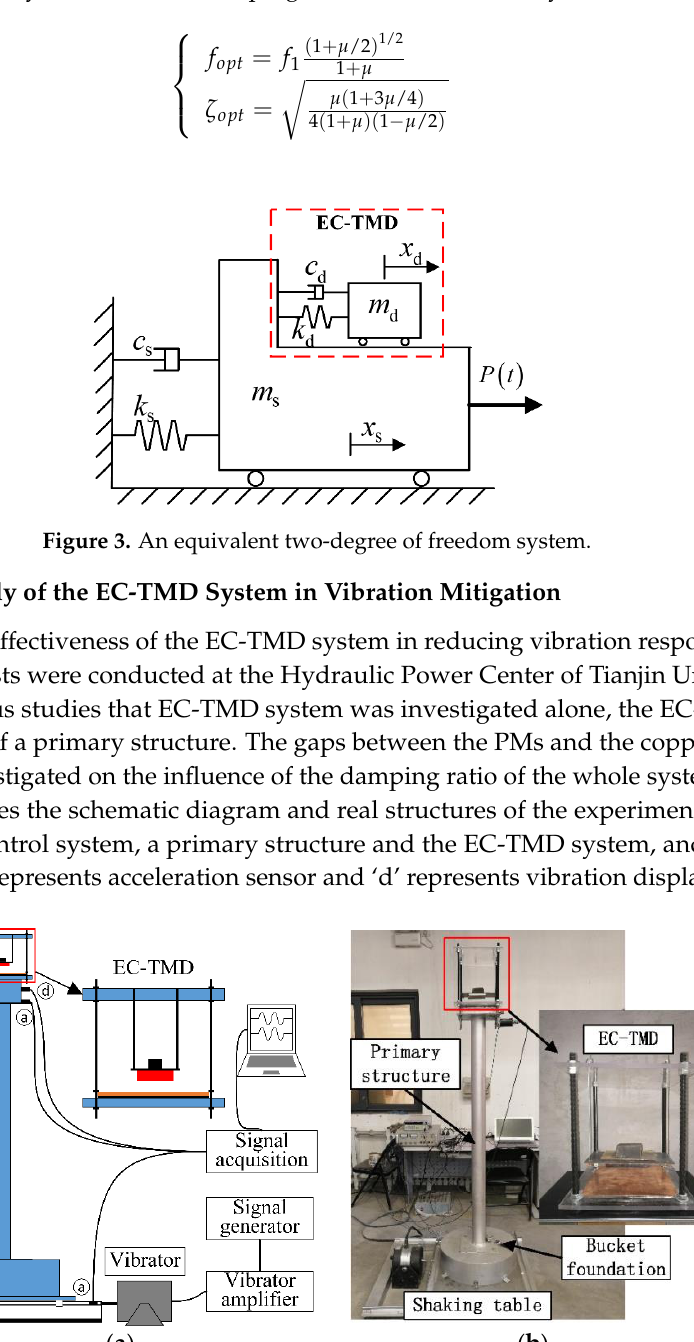
Figure 4. Experimental layouts of the EC-TMD system: ( a ) Layouts of the test; ( b ) Real structure of the test.